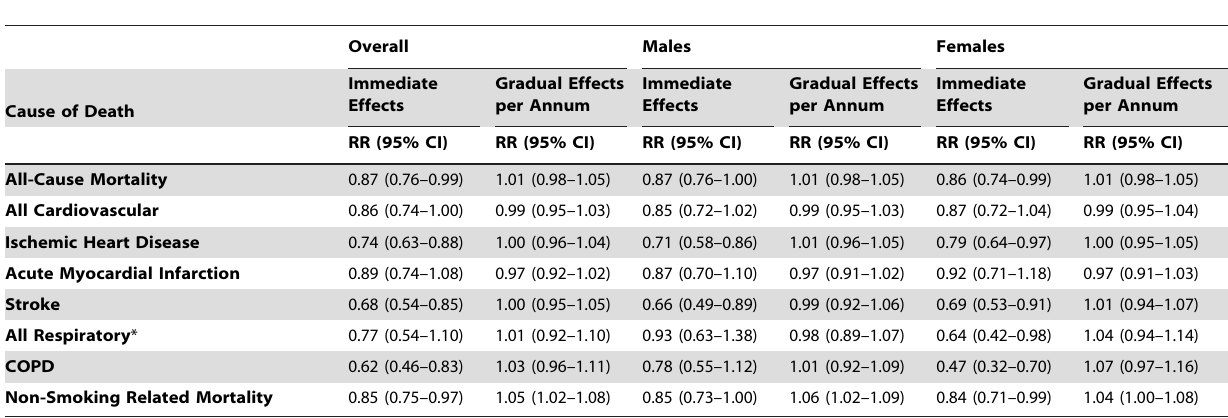
Table 1. Multivariate Analysis { of Overall and Gender-Specific Post-Ban Effects on Mortality Rates ` , Ages $ 35 years, Republic of Ireland,